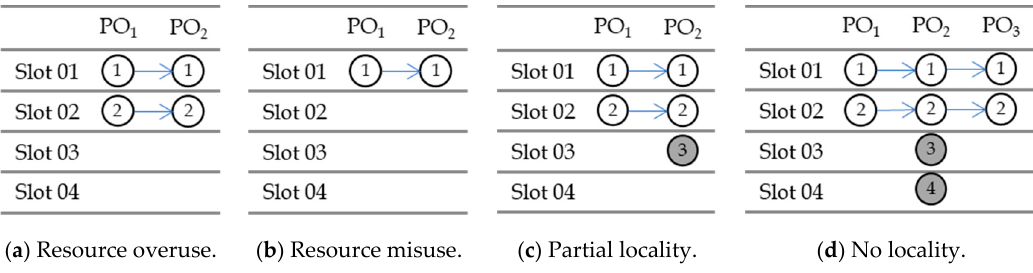
Figure 5. Examples of four problems solved by L/F job scheduler.